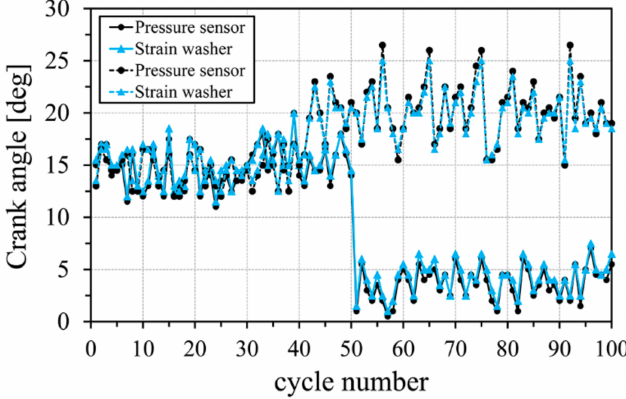
Figure 17. Angular position of the maximum in-cylinder pressure on 100 consecutive cycles evaluated by the pressure sensor and the strain washer by increasing the ignition advance of 20 CA deg (dashed line) and reducing it of 5 CA deg (solid line) at 4000 rpm and full